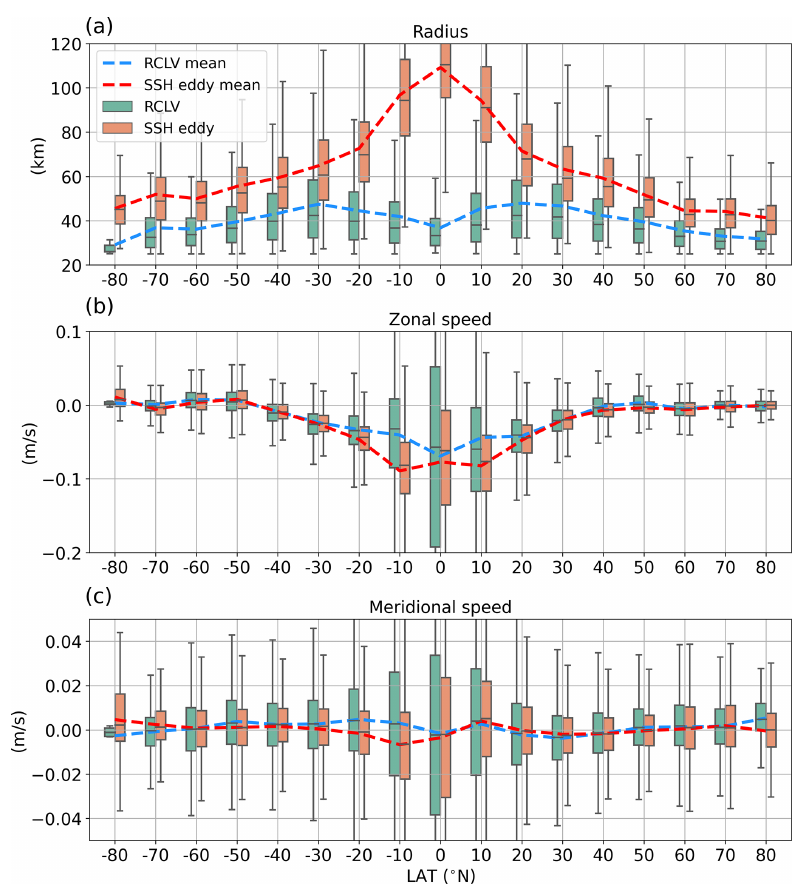
Figure 8. Statistics of (a) radius, (b) zonal propagation speed, and (c) meridional propagation speed for RCLVs and SSH eddies. The box plot shows statistics of all eddies in 10 ◦ bins. The box and the black whisker span the 25th to 75th and 10th to 90th percentiles of the distribution, respectively. The black line in the box indicates the median. The means of all eddies in a bin are shown using dashed lines, blue for RCLVs and red for SSH